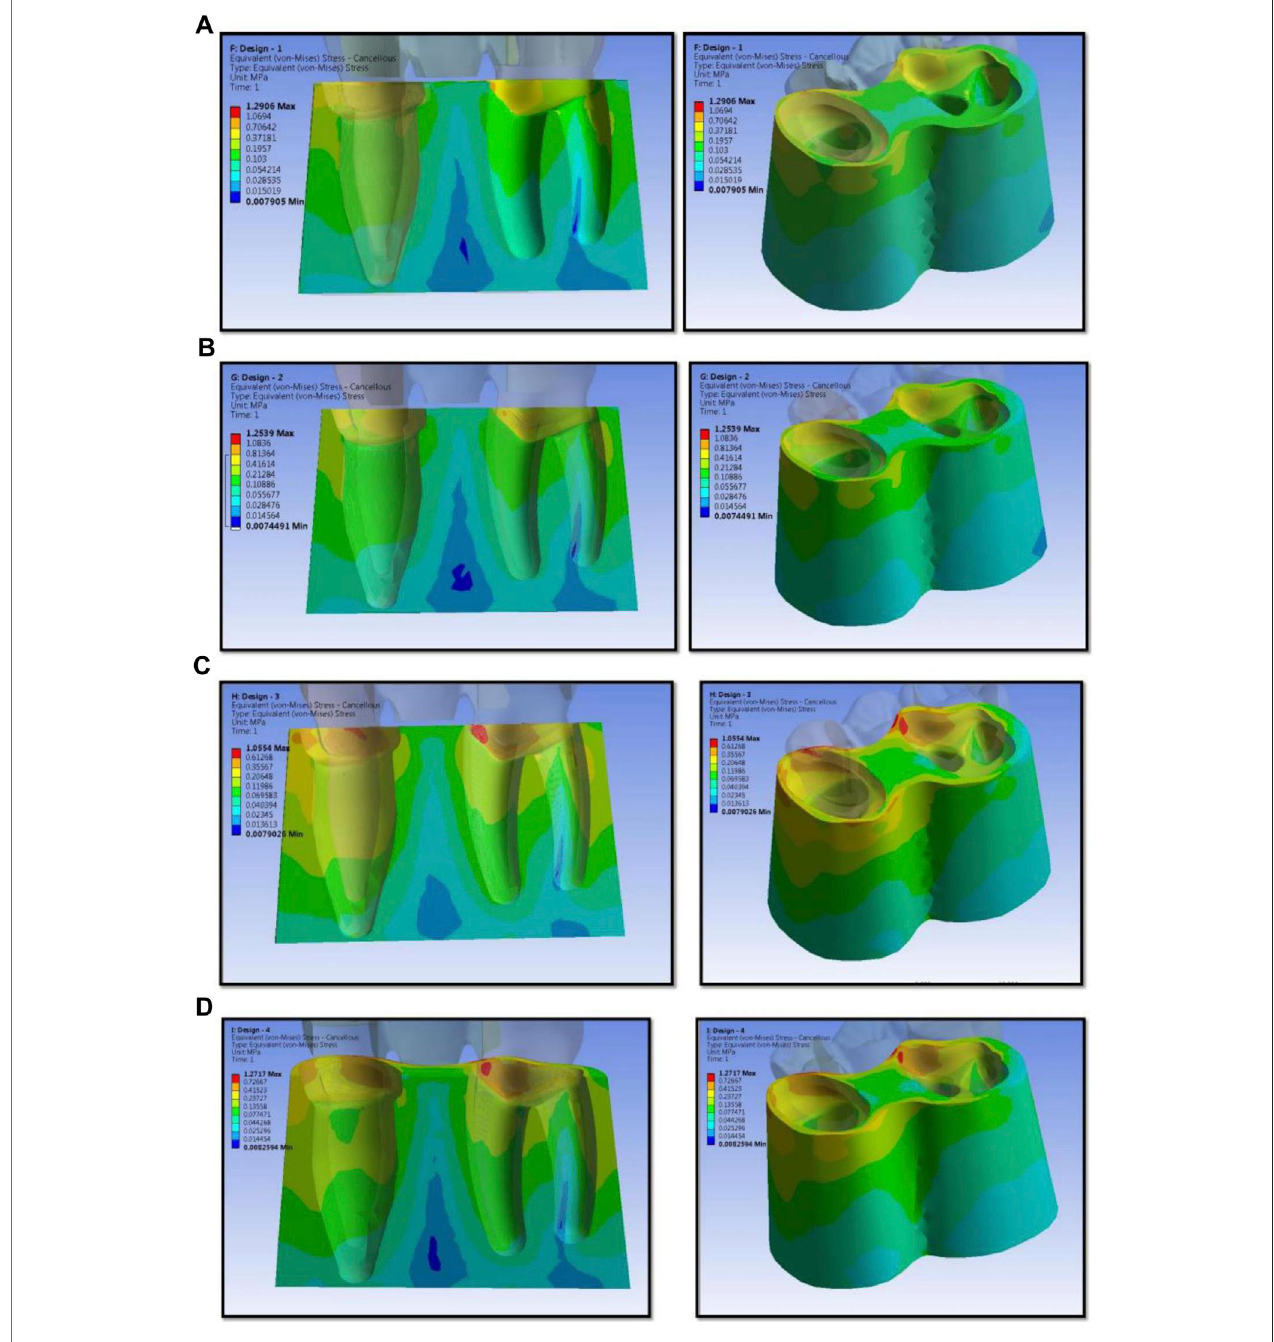
FIGURE 7 | Stress distribution on cancellous bone for design 1 (A) , design 2 (B) , design 3 (C) , and design 4 (D) used in fi nite element analysis.